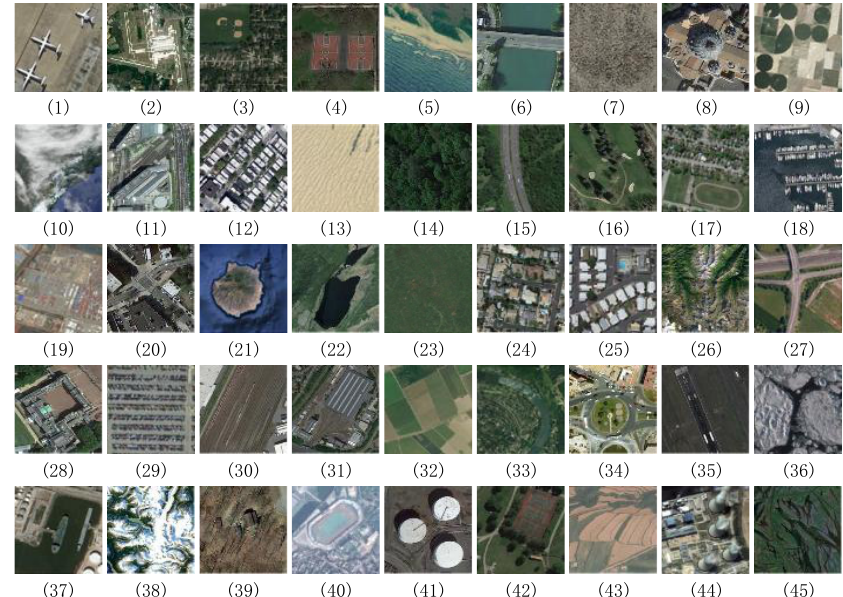
Figure 10. Class representatives of the NWPU-RESISC45 dataset: (1) Airplane; (2) Airport; (3) Baseball diamond; (4) Basketball court; (5) Beach; (6) Bridge; (7) Chaparral; (8) Church; (9) Circular farmland; (10) Cloud; (11) Commercial area; (12) Dense residential; (13) Desert; (14) Forest; (15) Freeway; (16) Golf course; (17) Ground track field; (18) Harbor; (19) Industrial area; (20) Intersection; (21) Island; (22) Lake; (23) Meadow; (24) Medium residential; (25) Mobile home park; (26) Mountain; (27) Overpass; (28) Palace; (29) Parking lot; (30) Railway; (31) Railway station; (32) Rectangular farmland; (33) River; (34) Roundabout; (35) Runway; (36) Sea ice; (37) Ship; (38) Snowberg; (39) Sparse residential; (40) Stadium; (41) Storage tank; (42) Tennis court; (43) Terrace; (44) Thermal power station; (45)